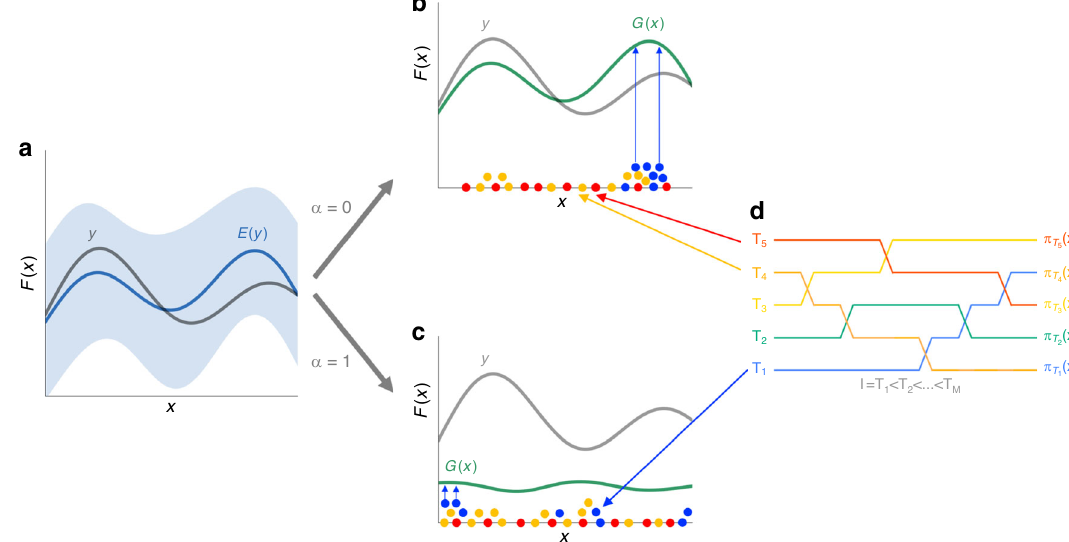
Fig. 3 ART chooses recommendations by sampling the modes of a surrogate function. The true response y (e.g., biofuel production to be optimized) is shown as a function of the input x (e.g., proteomics data), as well as the expected response E ( y ) after several DBTL cycles ( a ), and its 95% con fi dence interval (blue). Depending on whether we prefer to explore ( c ) the phase space where the model is least accurate or exploit ( b ) the predictive model to obtain the highest possible predicted responses, we will seek to optimize a surrogate function G ( x ) (Eq. (5)), where the exploitation-exploration parameter is α = 0 (pure exploitation), α = 1 (pure exploration) or anything in between. Parallel-tempering-based MCMC sampling ( d ) produces sets of vectors x (colored dots) for different “ temperatures ” : higher temperatures (red) explore the full phase space, while lower temperature chains (blue) concentrate in the nodes (optima) of G ( x ). The exchange between different “ temperatures ” provides more ef fi cient sampling without getting trapped in local optima. Final recommendations (upward-pointing blue arrows) to improve response are provided from the lowest temperature chain, and chosen such that they are not too close to each other and to experimental data (at least 20% difference). These recommendations are the “ Recommendations for next cycle ” depicted in Fig. 1. In this example, they represent protein expression levels that should be targeted to achieve predicted production levels. See Fig. 7 for an example of recommended protein pro fi les and their experimental